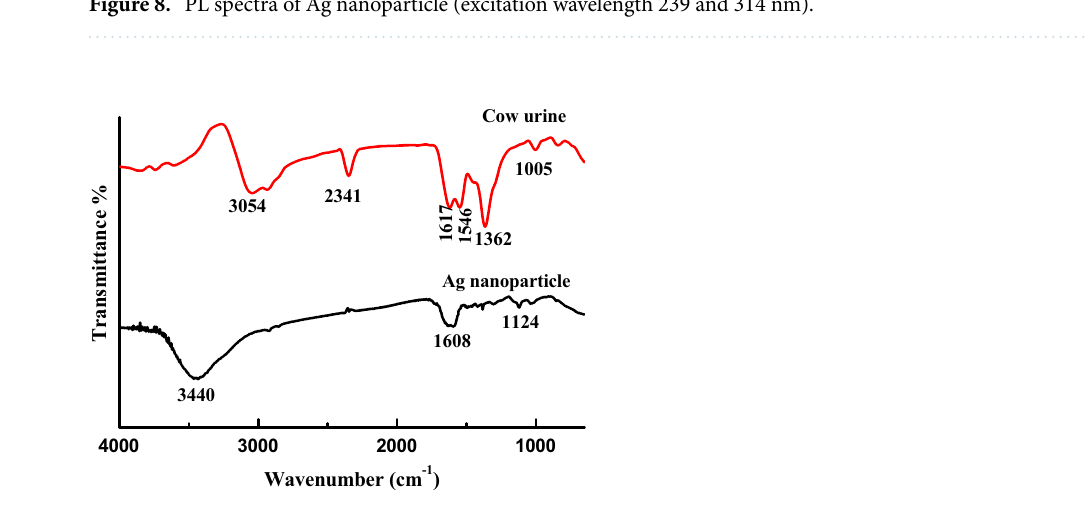
Figure 9. FT-IR spectra of cow urine and Ag